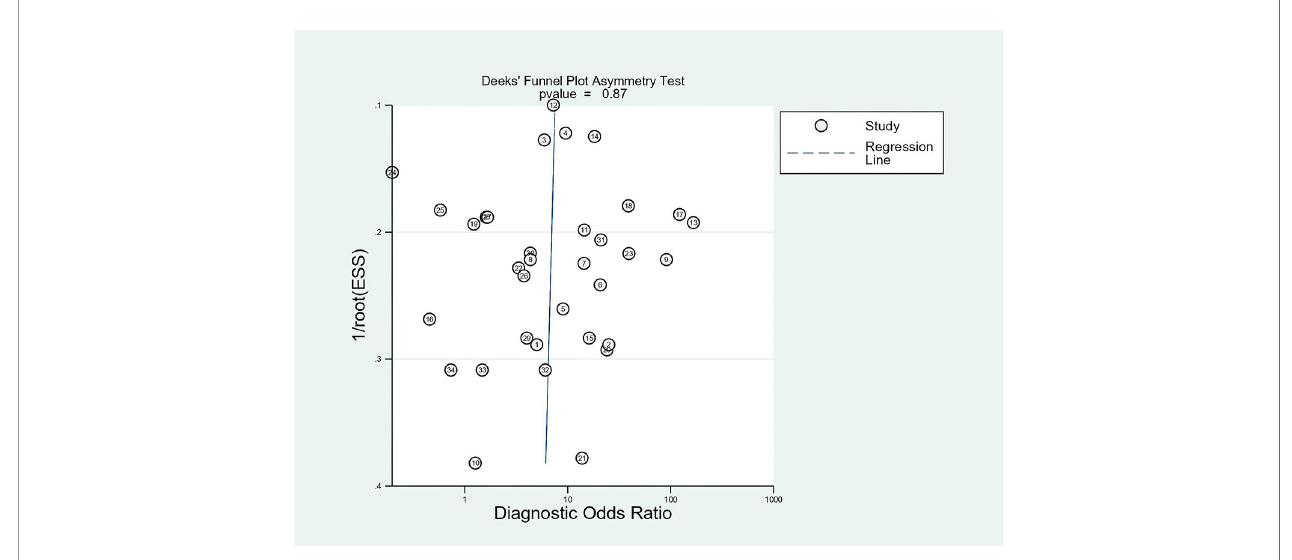
FIGURE 12 | The result of Deeks ’ funnel